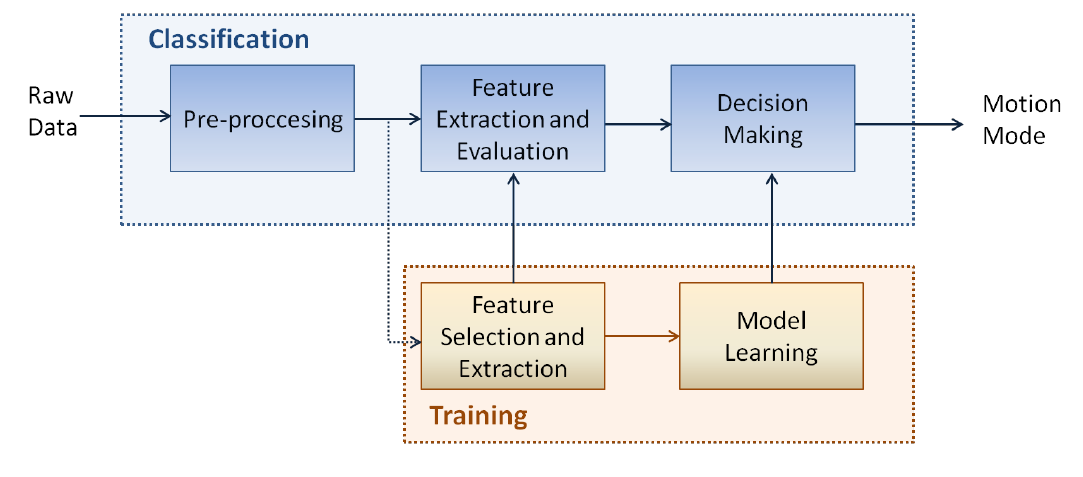
Figure 1. Scheme of a classifier for motion mode